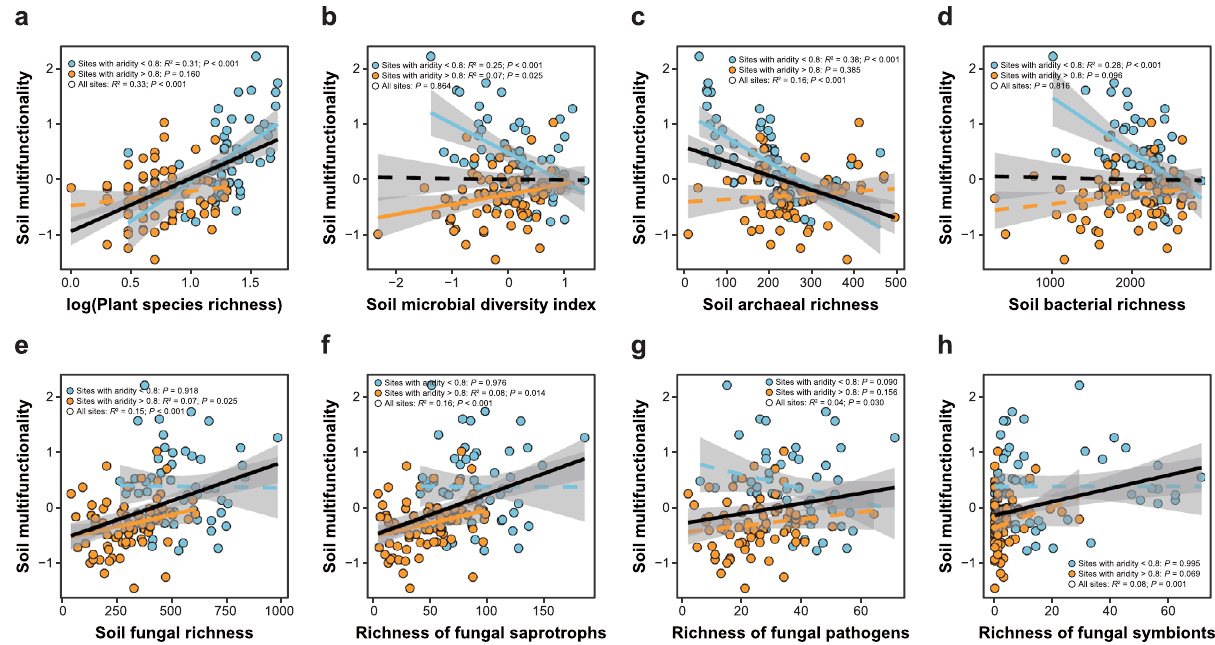
Fig. 4 Relationships between plant or soil microbial diversity and soil multifunctionality. a ‒ h Relationships between log-transformed plant species richness ( a ), soil microbial diversity index ( b ), soil archaeal richness ( c ), soil bacterial richness ( d ), soil fungal richness ( e ), richness of fungal saprotrophs ( f ), richness of fungal pathogens ( g ), and richness of fungal symbionts ( h ) and soil multifunctionality at sites with aridity <0.8 ( N = 54) and >0.8 ( N = 76), as well as across all fi eld sites ( N = 130; the black lines). Lines represent the fi tted linear OLS model. Solid and dashed lines denote statistically signi fi cant (two-sided P ≤ 0.05) and nonsigni fi cant (two-sided P > 0.05) relationships, respectively. Shaded areas denote the 95% con fi dence interval of the regression lines.